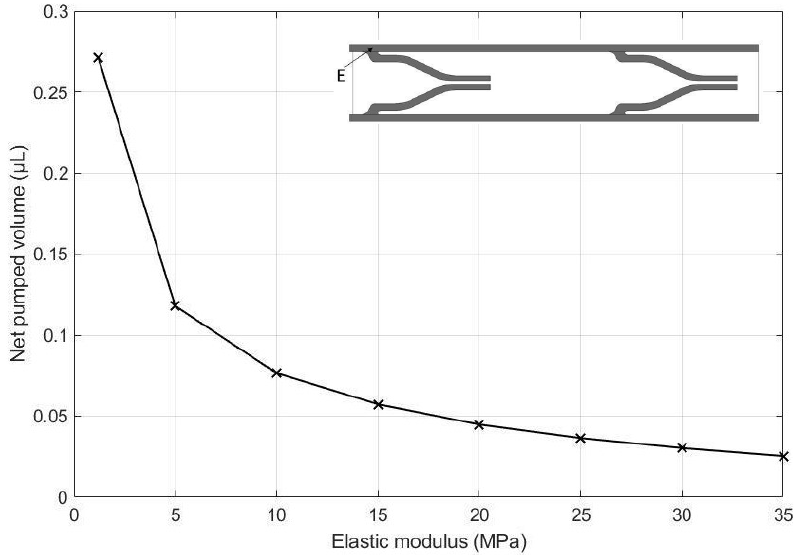
Figure 18. Effect of MRE elastic modulus on the net pumped volume.